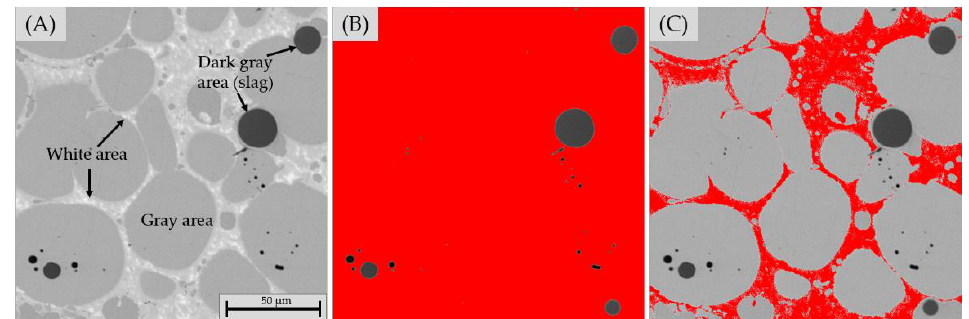
Figure 3. Typical microstructure of the metal alloy ( A ) with three different areas visible. ( B , C ) show the same image with the adjusted thresholds by ImageJ software. ( B ): image used for measuring the area percentage of white and gray phase together; ( C ): image used for measuring the area percentage of the white phase.